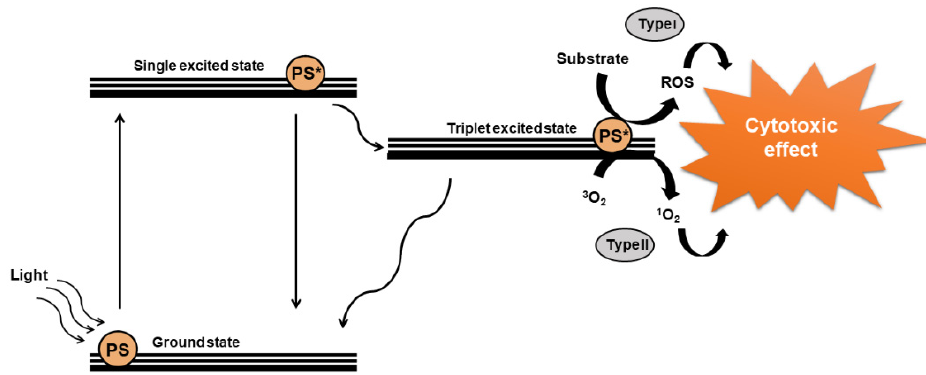
Figure 2. Jablonski diagram representation and the photodynamic therapy mechanism of action.